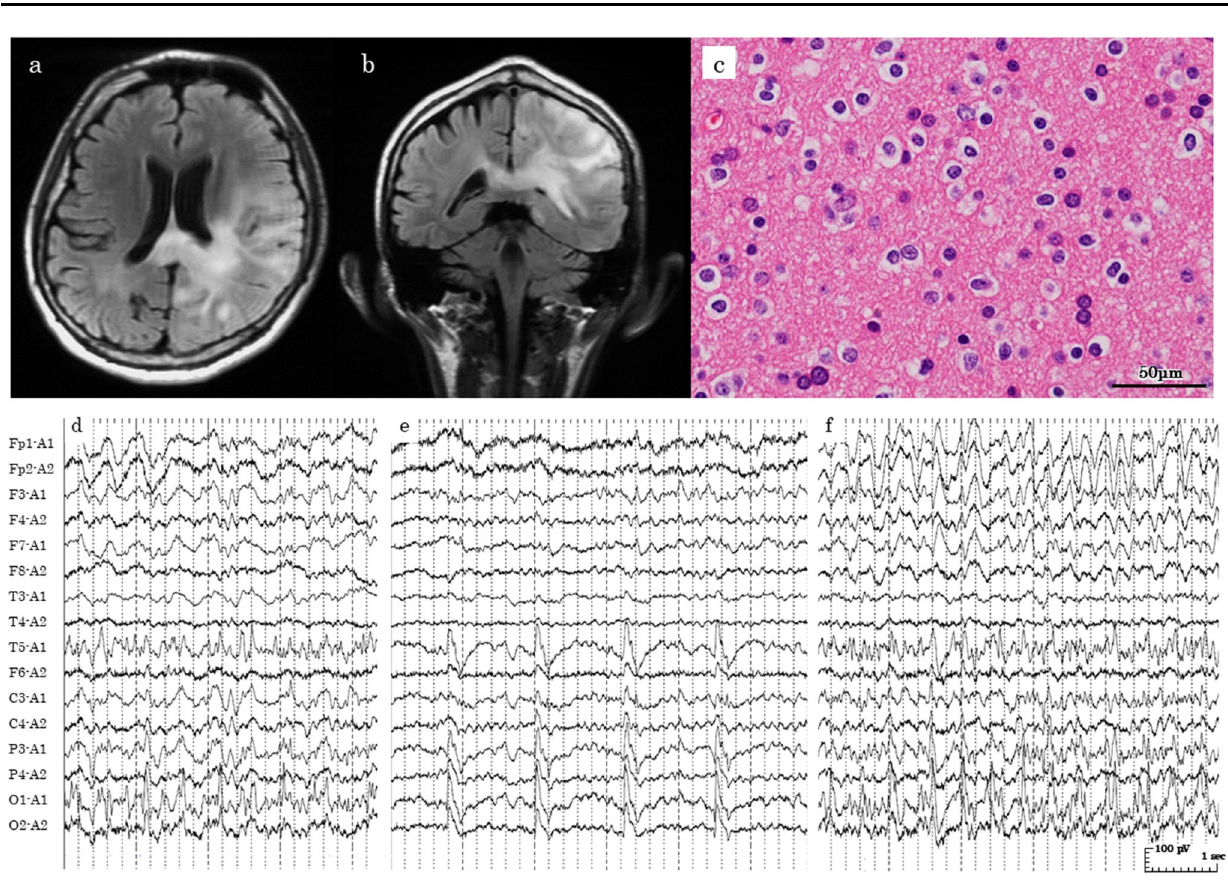
Fig. 2 MRI, histology and EEG of Case 5. a , b Preoperative axial and coronal FLAIR showed a hyperintense lesion on the left parieto-occipital lobe ( a axial plane, b coronal plane). c Hematoxylin and eosin staining (HE) of the tumor. Oligodendroglioma was confirmed pathologically. d Continuous epileptiform discharge with above 2.5Hz frequency mainly in the left occipital region during more than 10 s (O1, T5). e Rhyth- mic activity with ˃ 0.5 Hz frequency mainly in the occipito-temporal region (O1, T5). f Spatiotemporal evolution of epileptic discharge into the parietal region (C3,